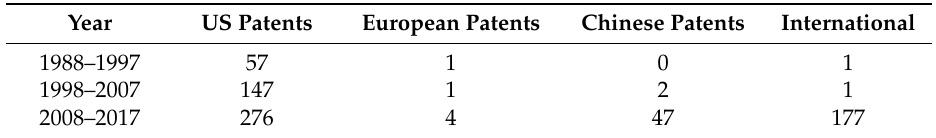
Table 1. Number of patents filed, organized by